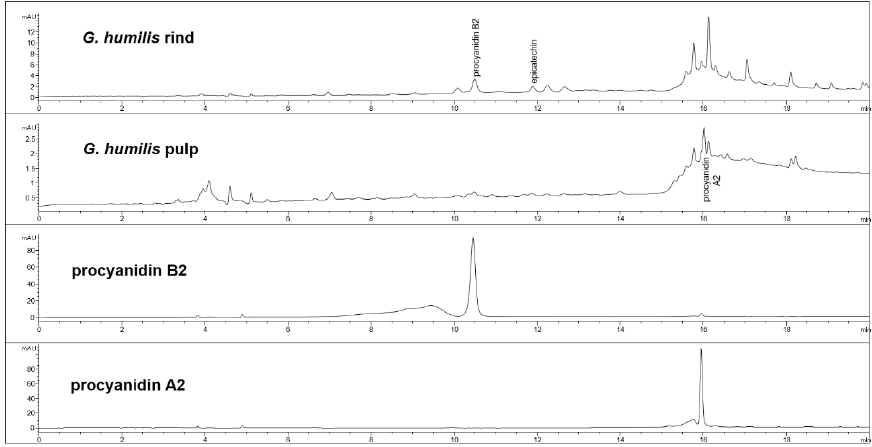
Figure 1. High-performance liquid chromatography (HPLC) chromatograms from Garcinia humilis rind and pulp for procyanidin analysis at 280 nm.